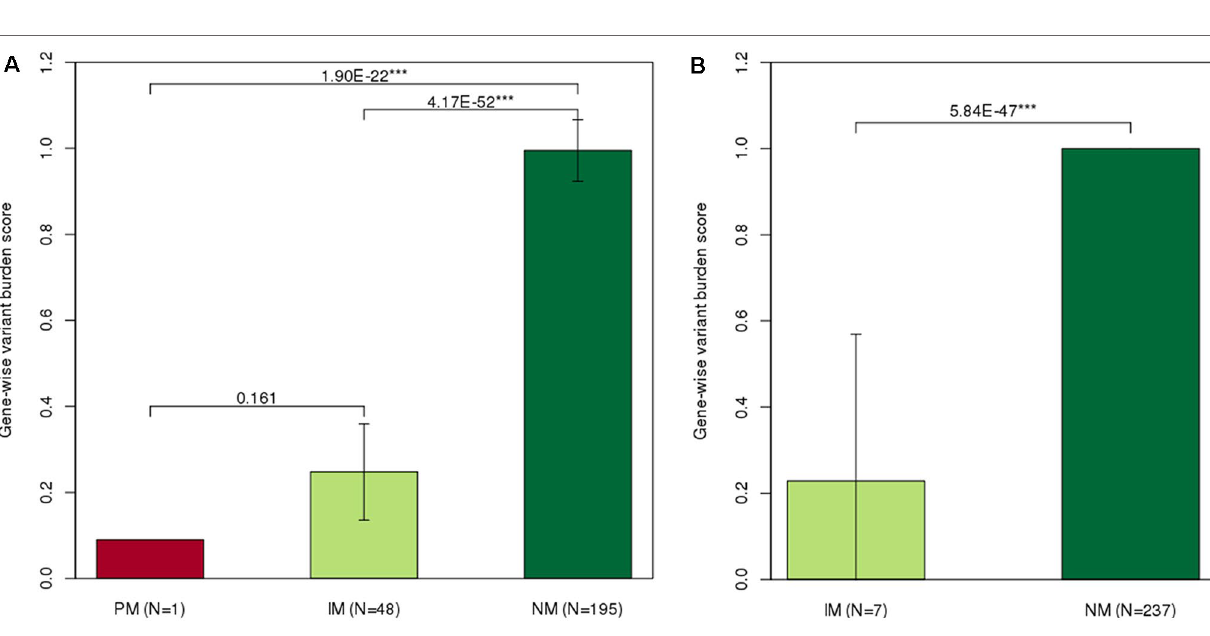
FIGURE 2 | Distribution of gene-wise variant burden (GVB) scores according to the star allele-based molecular phenotype groups. Gene-wise variant burden (GVB) scores across (A) NUDT15 and (B) TPMT molecular phenotype groups. Normal metabolizers showed significantly higher dose intensity percent than did intermediate ( NUDT15 , p = 4.17E−52; TPMT p = 5.84E−47) and poor ( NUDT15 , p = 1.9E−22) metabolizers. * p < 0.1, ** p < 0.05, and *** p < 0.01 by Mann–Whitney U